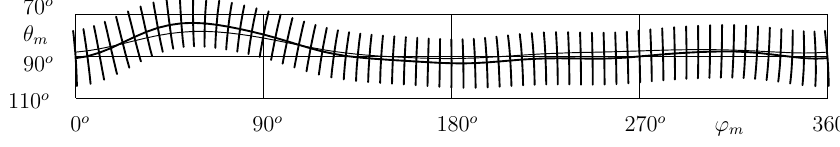
Fig. 4. Geomagnetic equator with segments of the magnetic field lines which start and finish at the height of 80km, and cross the geomagnetic equator at the height of 400km. A possible base surface near the geomagnetic equator is plotted by the thin